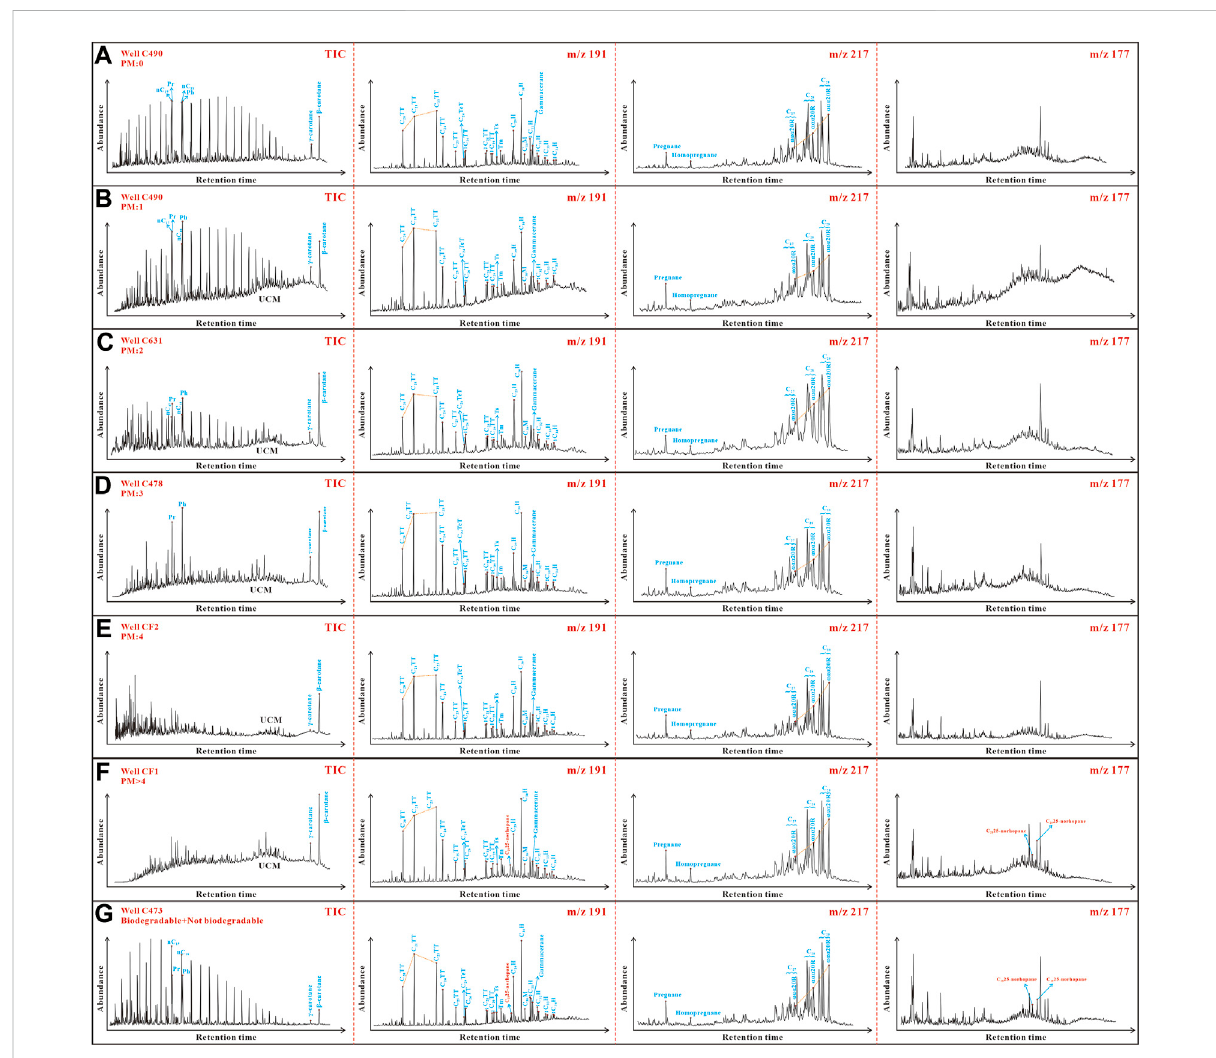
FIGURE 7 GC-MSofsaturatedhydrocarbonsinCarboniferouscrudeoilsamplesfromtheHongchefaultzone. (A) C490; (B) C490; (C) C631; (D) C478; (E) CF2; (F) CF1; (G)